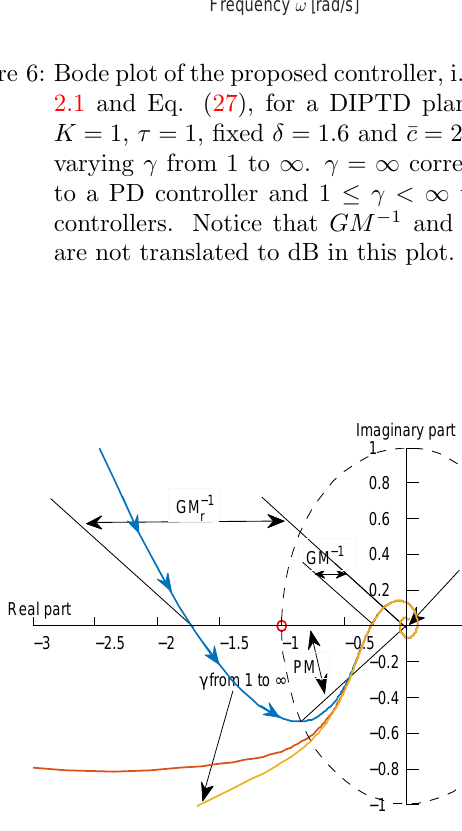
Figure 7: Nyquist plot of the proposed controller, i.e. Alg. 2.1 and Eq. (27), for a DIPTD plant with K = 1 and τ = 1, fixed δ = 1 . 6 and ¯ c = 2 . 1, and varying γ from 1 to ∞ . γ = ∞ correspond to a PD controller and 1 ≤ γ < ∞ to PID